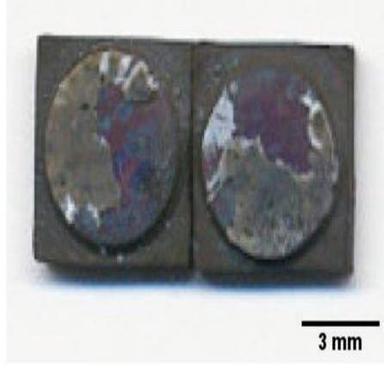
(a) fracture surfaces after torsion for a THG-5 sample joined by GC 1 and tested at 600 °C, showing mixed (i.e. adhesive/cohesive) behavior as sketched in (b), with GC1 being present on both fracture surfaces, as observed by SEM-EDS (c), with each region identified.